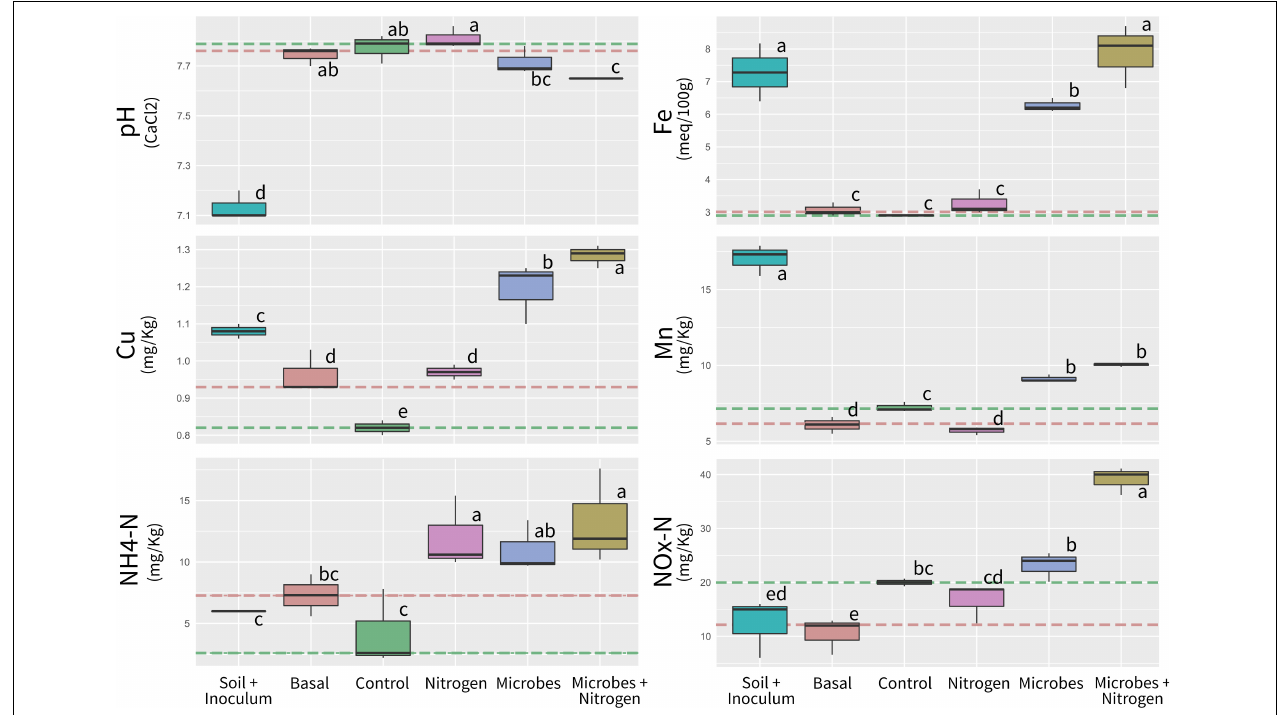
FIGURE 1 | Boxplot showing main soil chemistry parameters measured in the study. Orange and green segmented lines represent Basal (previous incubation) and Control (after incubation) levels. Boxplot sharing same letter coding are significantly similar ( p ≤ 0.05).